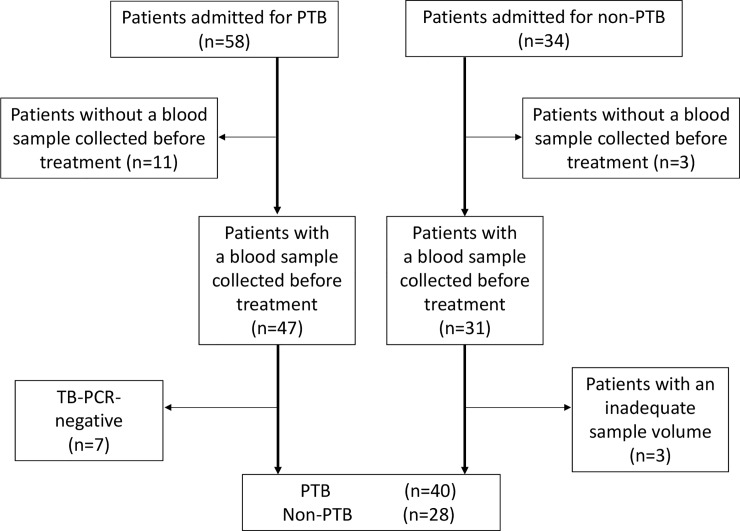
Flow chart showing the selection of PTB and non-PTB patients in this study.Eligible patients were further extracted by the inclusion criteria described in the Methods section. PCR, polymerase chain reaction; PTB, pulmonary tuberculosis.